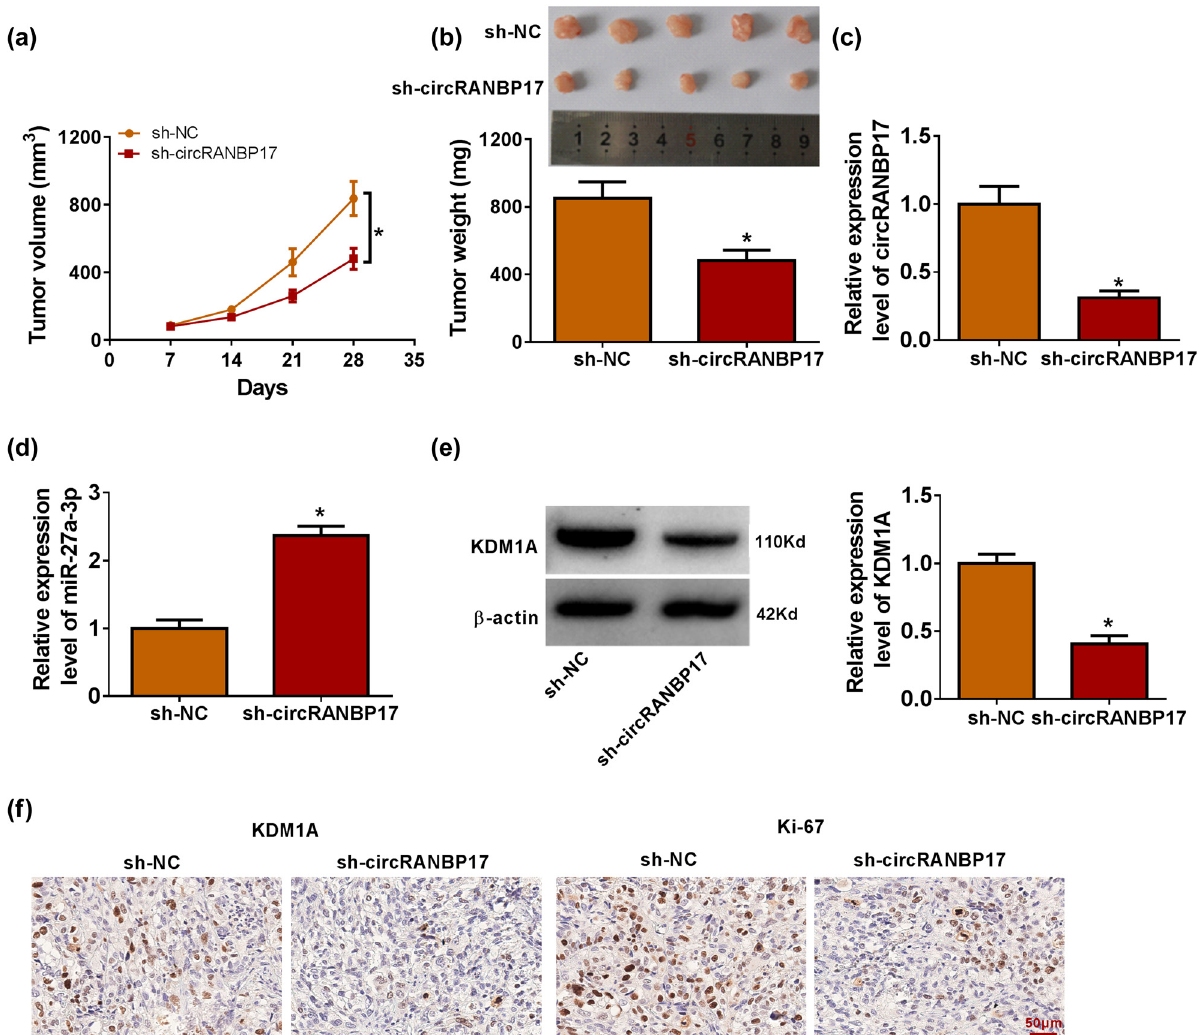
Figure 8: E ff ect of circRANBP17 knockdown on NB cell malignancy in vivo . ( a and b ) E ff ects of circRANBP17 depletion on tumor formation. ( c – e ) Impacts of circRANBP17 silencing on the expression of circRANBP17, miR - 27b - 3p and KDM1A were determined by qRT - PCR or western blot in the forming tumors from sh - circRANBP17 or sh - NC group. ( f ) Positive expression rates of KDM1A and Ki - 67 were evaluated by IHC assay. * P <